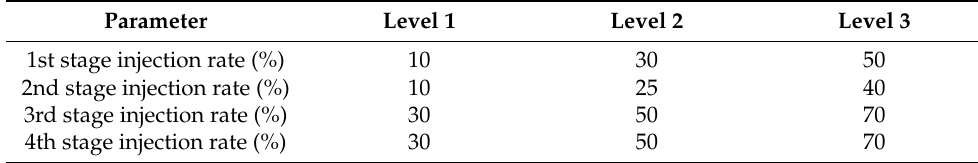
Table 2. Injection molding parameters of Suspension S-60 PVC.